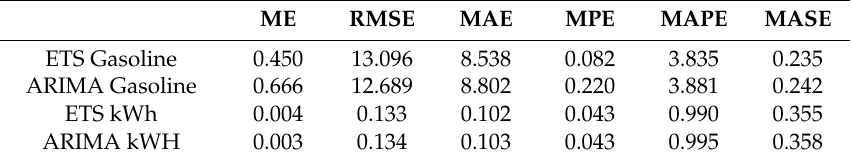
Table 3. The accuracy metrics for the forecast models are shown below. ME is the mean error (a measure of bias), RMSE is the root mean squared error (a measure of variability), MAE is the mean absolute error (a measure of variability), MPE is the mean percent error (a measure of bias), MAPE is the mean absolute percent error (a measure of variability), and MASE is the mean absolute scaled error (a comparative measure of performance versus the seasonal naïve with lower values meaning better performance. ME